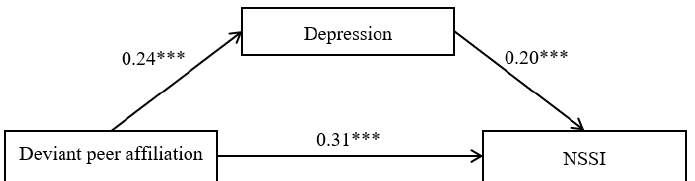
Figure 2. Model of the mediating role of depression in the association between deviant peer affiliation and non-suicidal self-injury. Note: the numbers are standardized regression coefficients. Path coefficients between control variables (gender and age) and each of the variables in the model are not displayed. Gender was dummy coded as 1 = male, 0 = female. Of those paths, gender was sig- nificantly related to depression ( b = − 0.14, SE = 0.04, t = − 4.13, p < 0.001) and NSSI ( b = − 0.08, SE = 0.04, t = − 2.08, p < 0.05). NSSI = non-suicidal self-injury. *** p < 0.001.